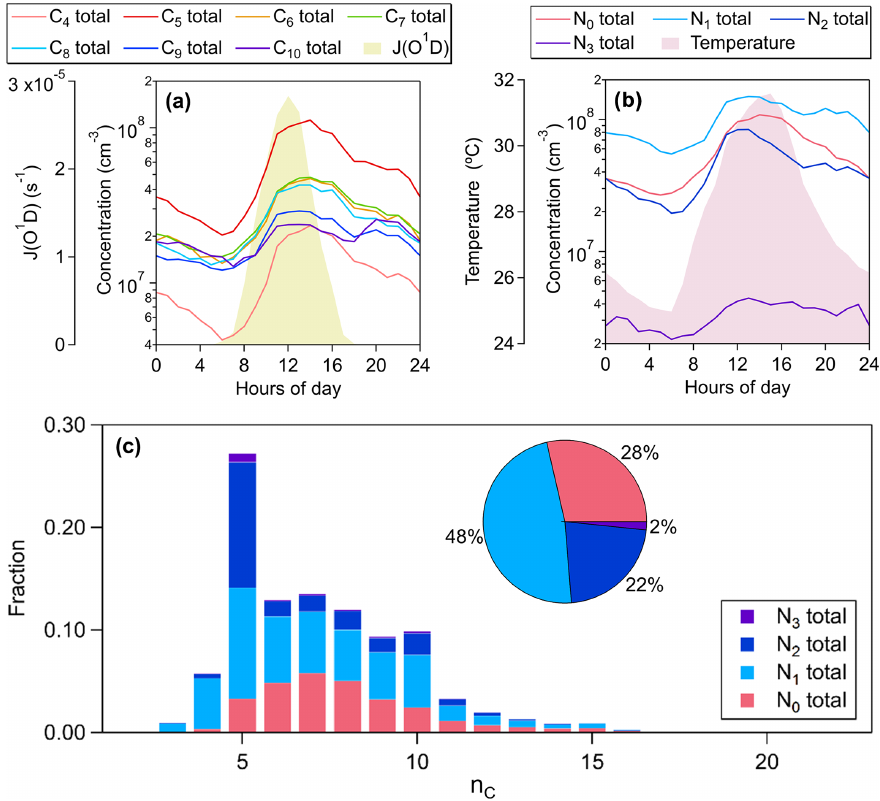
Figure 12. Ensemble chemical properties of non-nitro OOMs reconstructed from the selected PMF solution. (a) Median diurnal cycles of total compounds with a carbon number of 5–10. (b) Median diurnal cycles of total compounds with n N of 0–3. (c) The distributions of total observed OOMs at different n C values. OOMs on each carbon number are grouped by nitrogen number, and the total concentration fractions of each groups are reported in the pie chart. Since we selected peaks in the m/z range of 202–404Th, OOMs with n C < 5 or n C > 10 detected by the nitrate CI-APi-TOF are